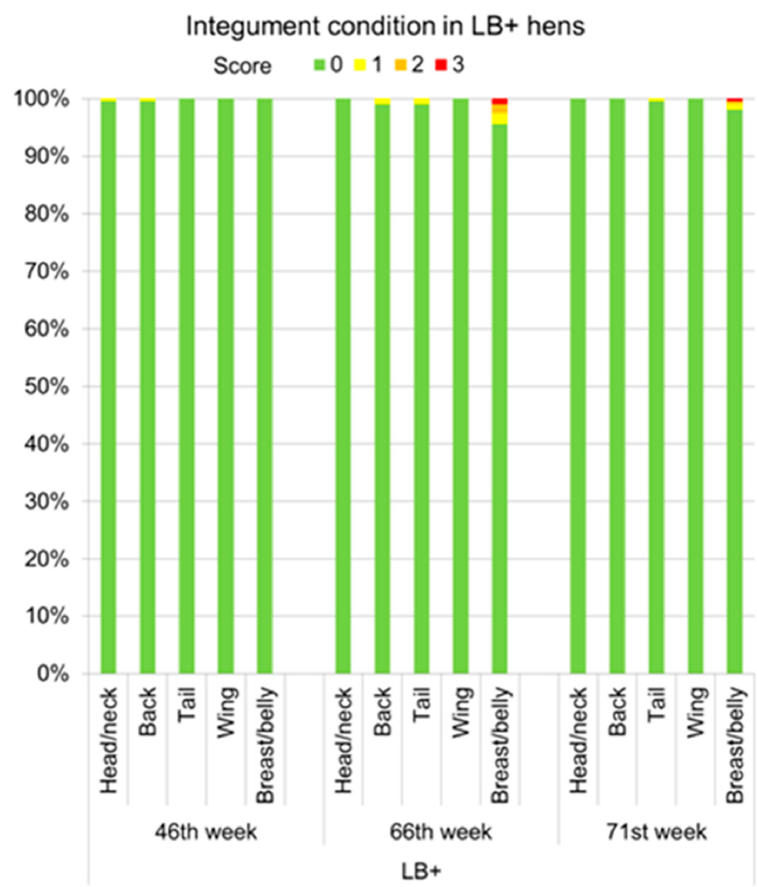
Figure 3. Proportions of LB+ hens ( n = 200) with different integument scores (0 (best) to 4 (worst)) for head/neck, back, tail, wing, and breast/belly obtained by the VSc method in the 46th, 66th, and 71st week of